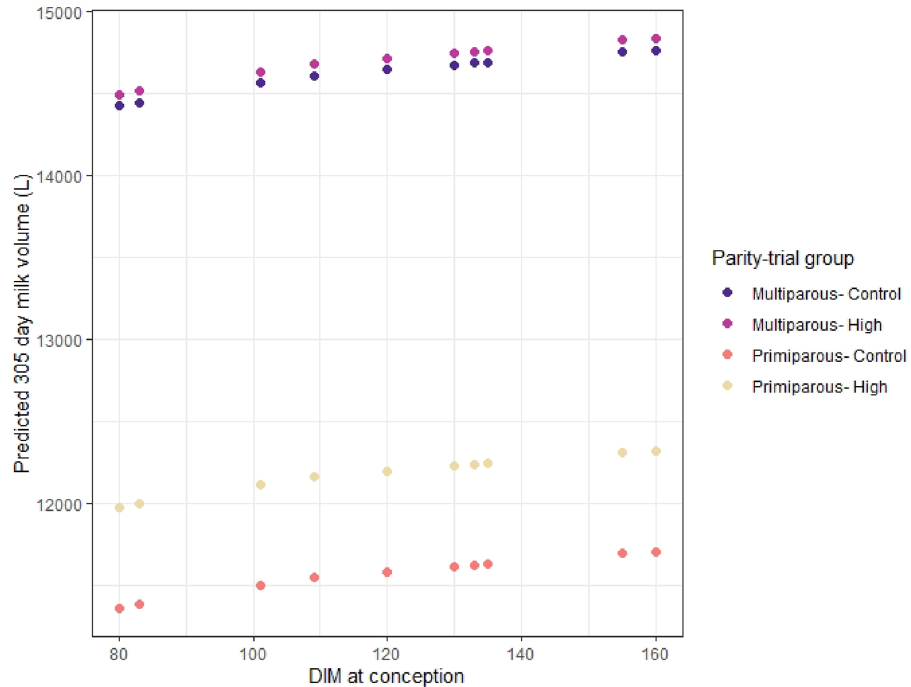
Figure 3. Scatterplot to illustrate the predicted 305-day milk yields (y-axis) by days in milk (DIM) at which a cow conceived (x-axis) based on data collected from a long-term randomised controlled trial to assess the impact of living space on housed dairy cows. The predictions are grouped by parity-trial